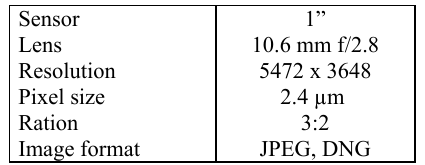
Table 1. Main specifications of the used S.O.D.A. camera.